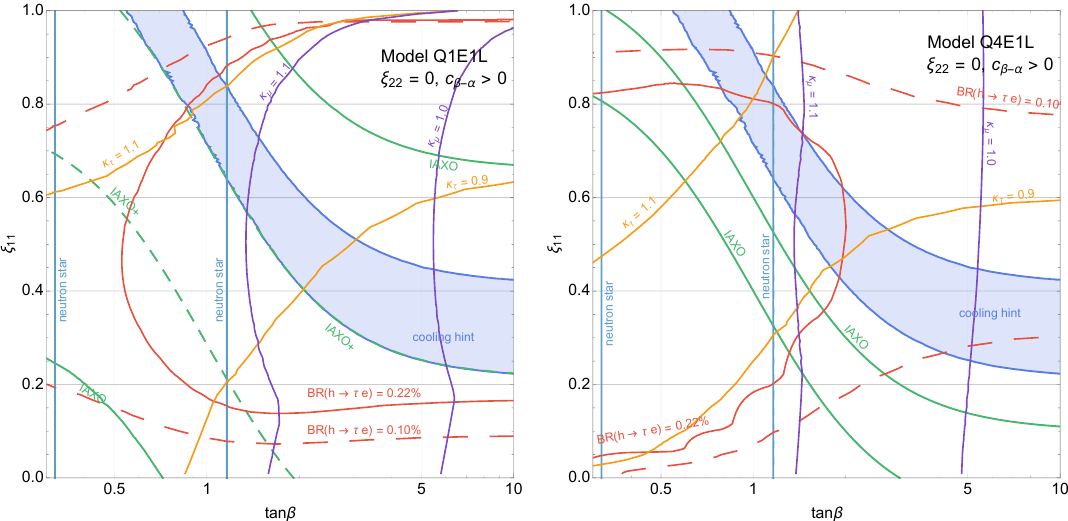
Figure 4 . Contours of BR ( h → τe ) (solid, dashed and dotted red), κ τ (orange), κ µ (purple) obtained by taking the maximal value of c β − α > 0 allowed by LHC Higgs coupling measurements. The blue region is preferred at 1 σ by stellar cooling hints, the future helioscopes IAXO (IAXO+) will probe the whole region except the one between the green (dashed green) curves, and the region between light blue curves satisfies the neutron star bound for f a = 10 9